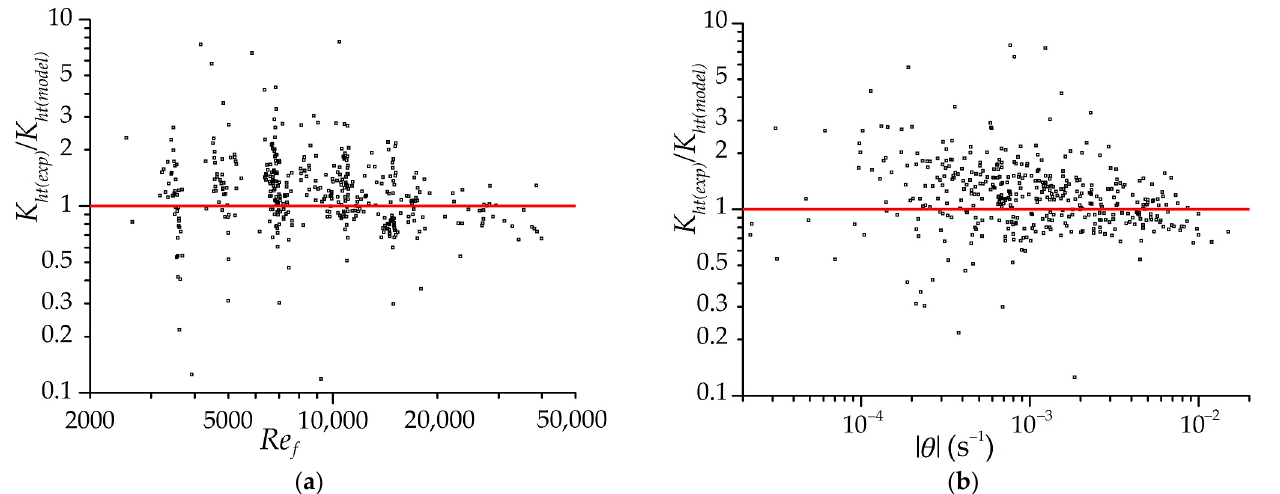
Figure 10. The distributions of the ratio of the estimated experimental heat transfer coefficients to the coefficients determined by Equation (9) depending on the Reynolds number ( a ) and the relative change in the gas temperature 𝜃 ( b ). Dots are separate measurements. The line is an exact match to the empirical Equation (9).